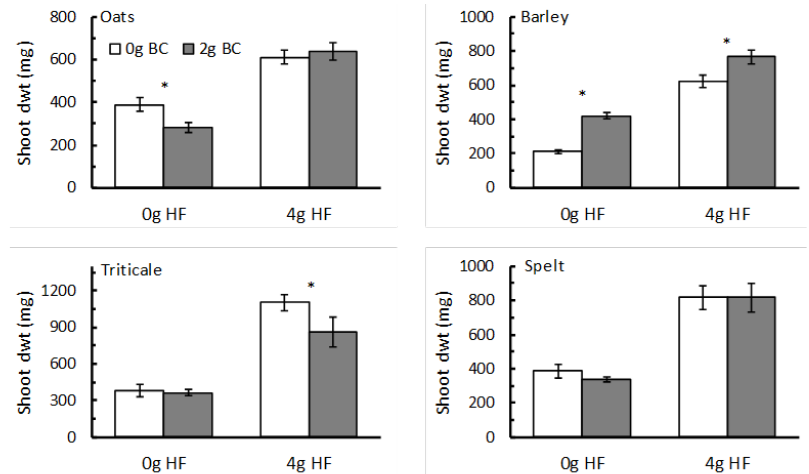
Figure 3. The response of oats, barley, triticale, and spelt (shoot dry weight; dwt; mg; mean ± se; N = 8) to addition of HexaFrass (HF; 0 g or 4 g/pot) and biochar (BC; 0 g/pot—white columns; 2 g/pot—dark columns)). *—significant difference between biochar treatments for the same HF level as indicated by Fisher’s LSD ( p < 0.05).